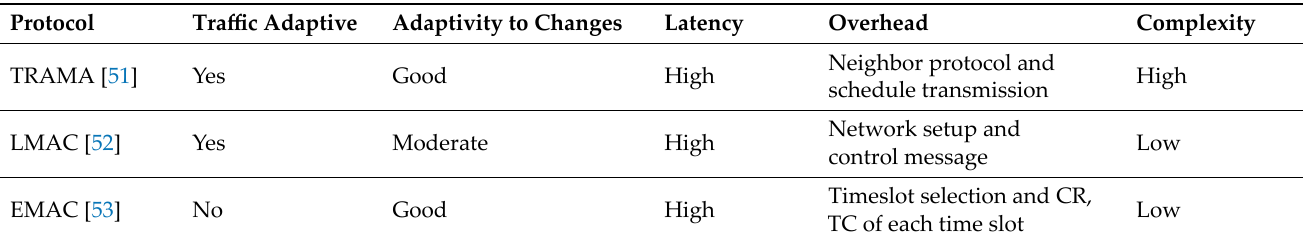
Table 4. Schedule based protocols comparison with